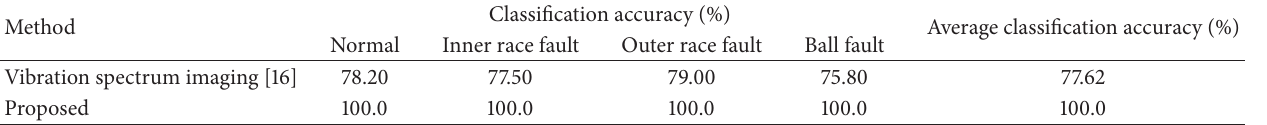
Table 5: Comparison of classification accuracy between existing BSI and the proposed method.